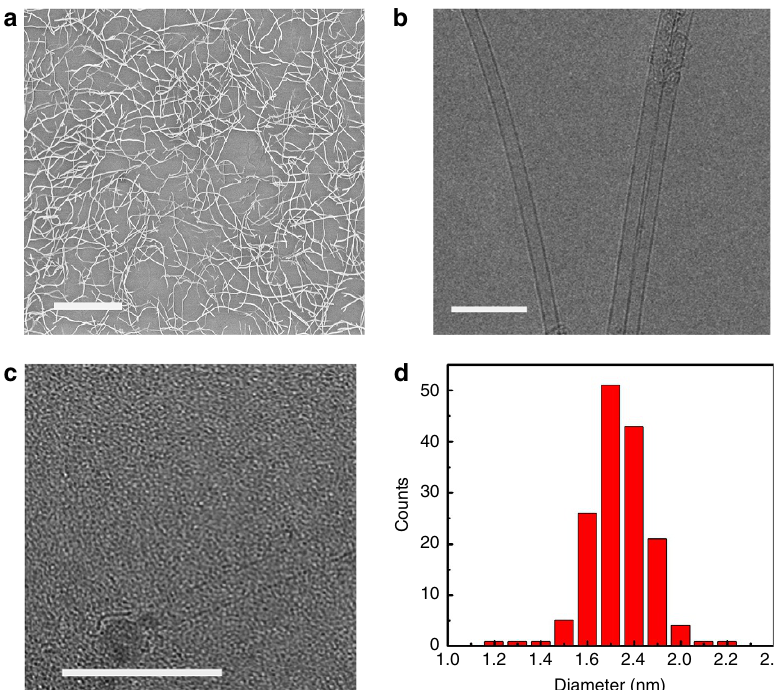
Figure 3 | SEM and TEM observations of the as-prepared SWCNTs. SEM ( a ) and TEM ( b , c ) image of the as-prepared SWCNTs. Scale bar, 10 m m ( a ) and 10nm ( b , c ). ( d ) Diameter distribution of the SWCNTs based on TEM